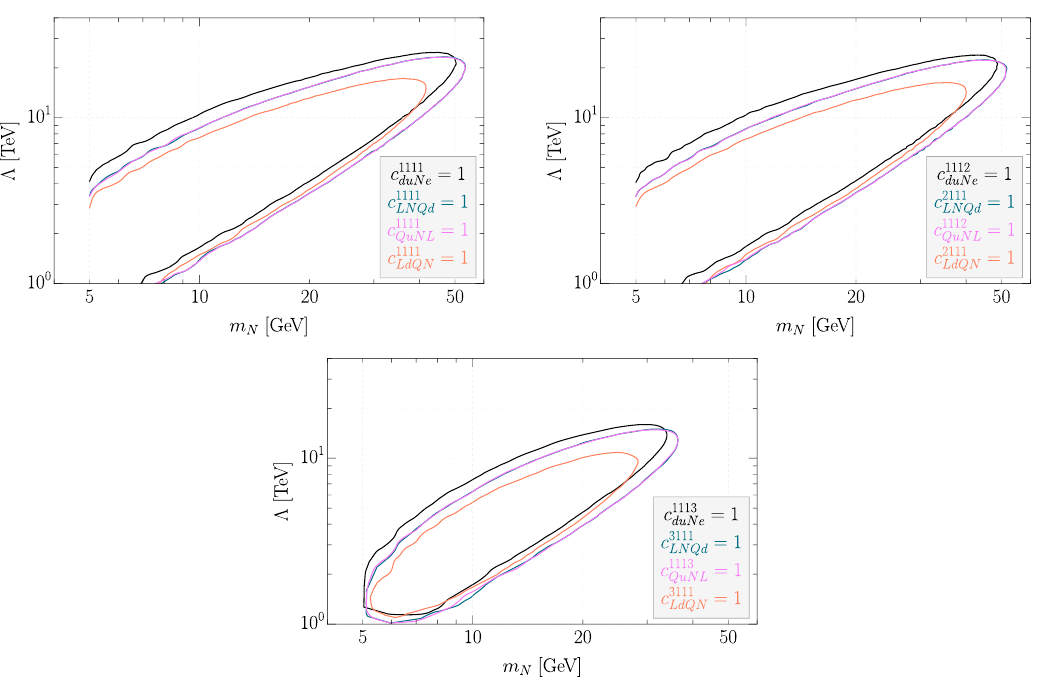
Figure 2 . Exclusion limits on the new physics scale Λ as a function of m N in the EFT scenario with operators including the first-generation quarks only, for an integrated luminosity of 3 ab − 1 . The two plots at the top consider operators with charged leptons of the first and second generation: electrons (left) and muons (right). The plot at the bottom considers operators with tau leptons